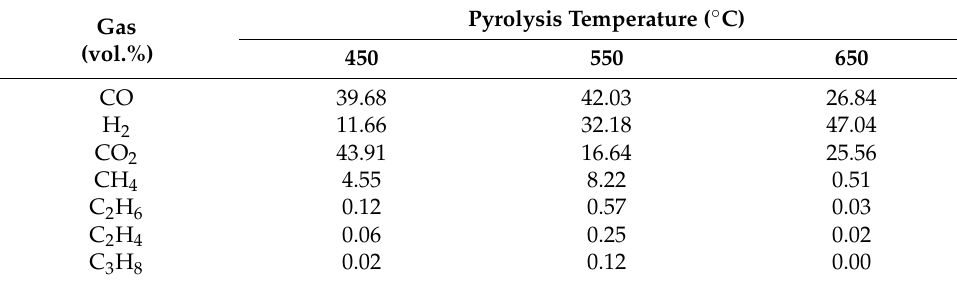
Table 6. The gas product from microwave pyrolysis of CF/EP prepreg.